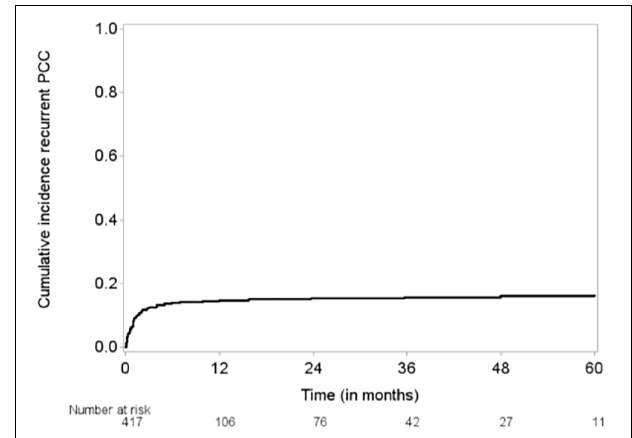
FIGURE 1 | Kaplan-Meier curve for overall survival (OS). Outcome for 1 patient was missing.